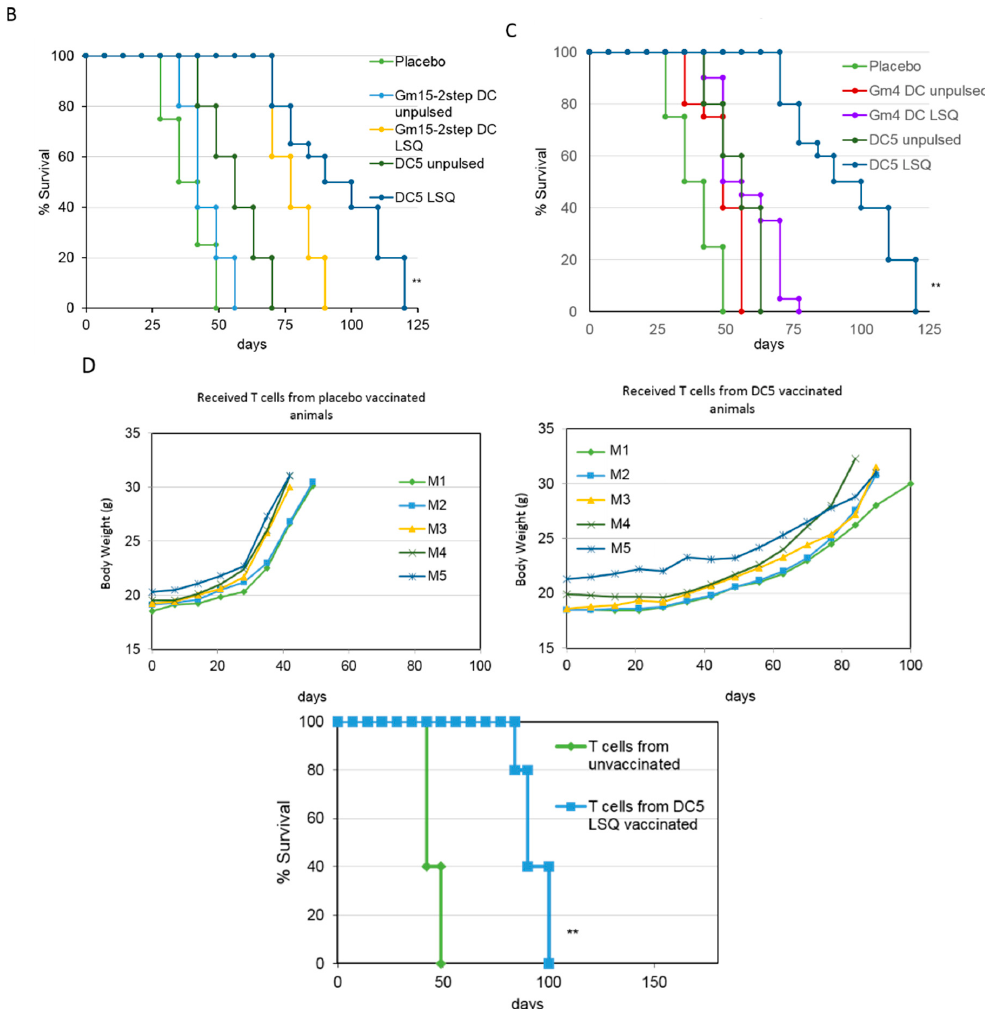
Figure 6. Blocking the prostaglandin E 2 pathway during DC differentiation and maturation prolongs animal survival in a vaccination mouse model of ovarian cancer. ( A – C ) Mice were inoculated i.p. with ID8-fast cells at day 0, followed by i.p. vaccination with the indicated DC formulations at day 7, 14 and 21 ( n ≥ 5 for each group). Body weight and animal survival were evaluated and plotted in Kaplan–Meier cumulative survival plots. Student’s t test results (comparing DC5 LSQ DCs to both GM15-2 step LSQ and classical GM4-1 step LSQ DCs) are indicated with an asterisk: ** p < 0.01 ( D ) Animals were vaccinated as reported above; T cells were then isolated from inguinal LN on day 28 post tumor inoculation and injected in the tail vein of recipient mice 3 days before tumor challenge with i.p. injection of ID8 fast cells. Body weight and animal survival were evaluated and plotted in Kaplan–Meier cumulative survival plots. Student’s t test results are indicated with an asterisk: ** p < 0.01. (DC: dendritic cells).